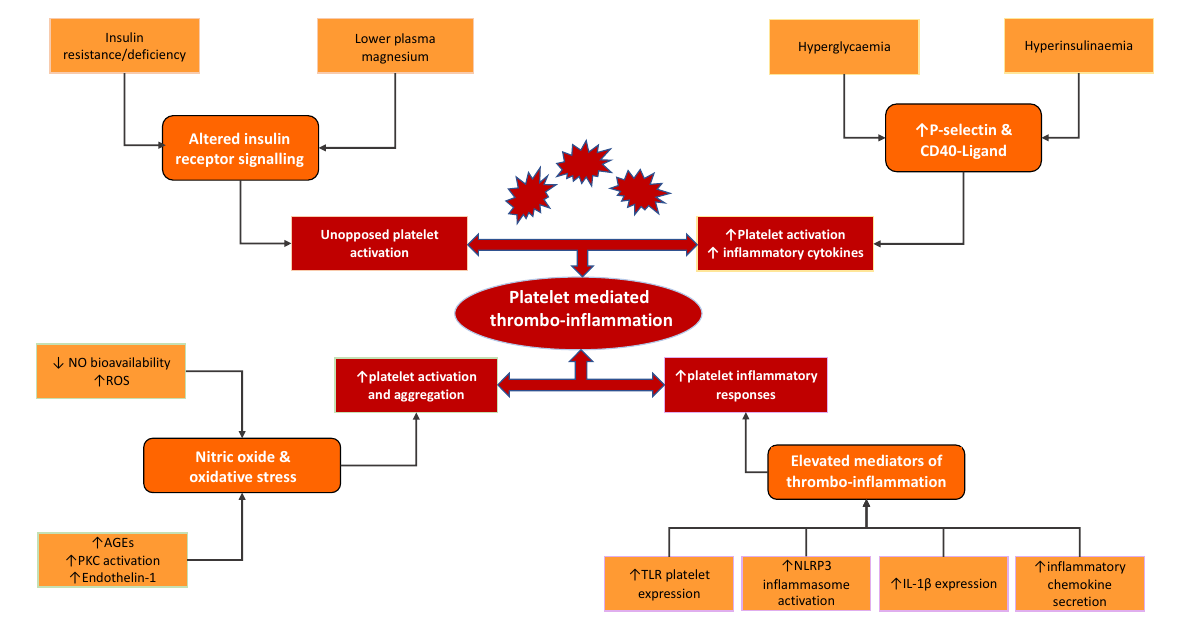
Figure 2. Factors present in diabetes that drive unopposed platelet activation, increased platelet activation and release of inflammatory cytokines, increased platelet aggregation and also elevated platelet inflammatory responses. Abbreviations; NO: nitric oxide, ROS: reactive oxygen species, AGEs: Advanced Glycation End Products, PKC: protein kinase C, TLR: Toll ‐ like receptor, NLRP3: NOD ‐ like receptor protein 3, IL ‐ 1 β : interleukin ‐ 1 β .